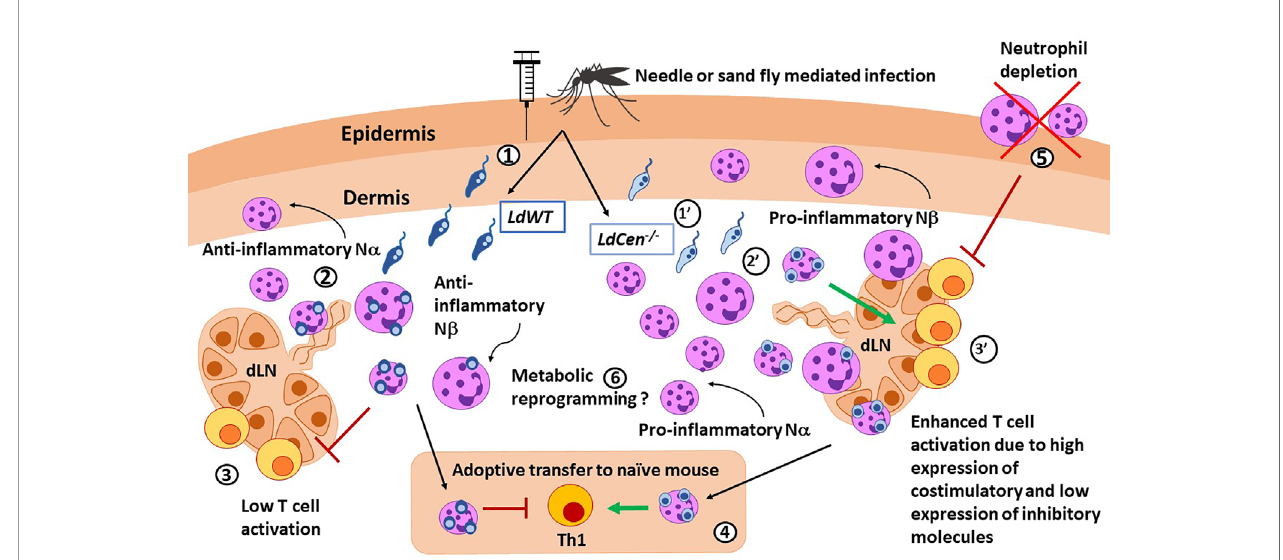
FIGURE 1 | Role of neutrophils in immunity against Leishmania parasites. LdWT (1) or Ldcen -/- (1 ’ ) parasites are injected with a needle or by the sand fl y vector. Compared with LdWT infection (2), LdCen − / − (2 ’ ) parasites induce higher recruitment of neutrophils, especially the smaller N a subtype, to the ear dermis and ear draining lymph nodes (dLN), which were predominantly proin fl ammatory in nature. Similar N a and N b subtypes were reported in live attenuated HSV vaccine studies. Neutrophils from ear dLN of LdCen − / − -immunized (3 ’ ) mice exhibited heightened expression of costimulatory molecules and attenuated expression of coinhibitory molecules necessary for higher T cell activation compared to LdWT (3). 4) Adoptive transfer of neutrophils bearing LdCen − / − parasites induced an increased Th1 response in naive mice compared to LdWT . 5) Neutrophil depletion signi fi cantly abrogated Ag-speci fi c CD4+ T cell proliferation in LdCen − / − -immunized mice and impaired protection against virulent challenge. Conversely, replenishing of neutrophils signi fi cantly restored the LdCen − / − -induced host-protective response. 6) Neutrophils can undergo metabolic reprogramming to acquire trained immunity characteristics as shown in BCG vaccination